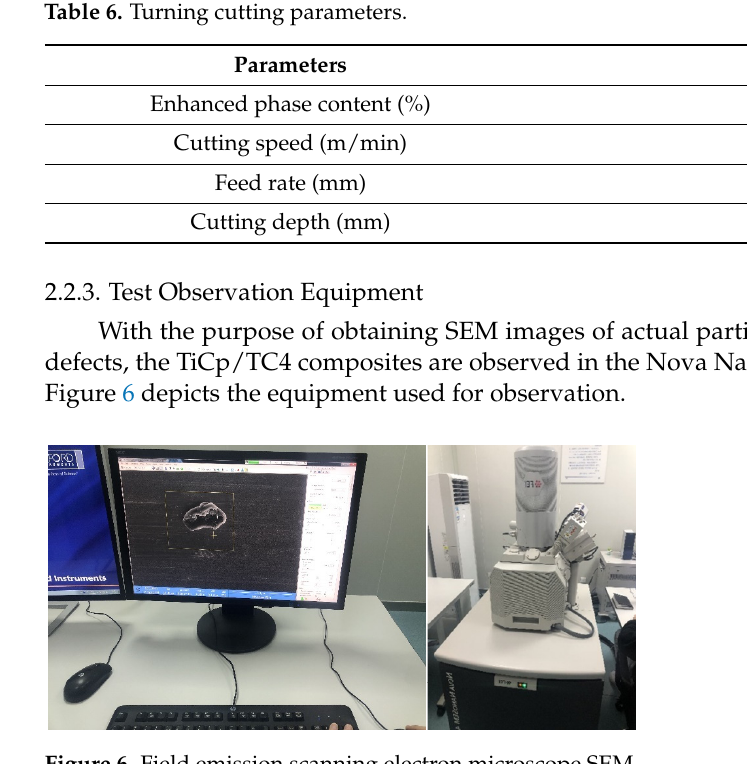
Table 5. PCD tool working angle and grain size.